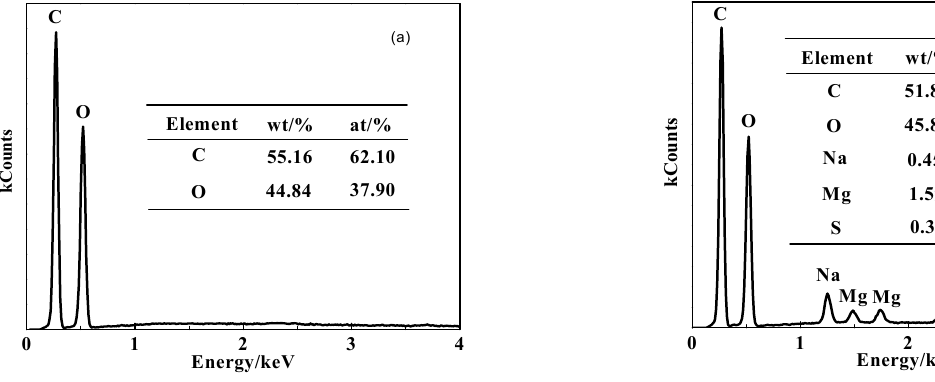
Figure 6. EDS images of ( a ) DG and ( b ) MDG.